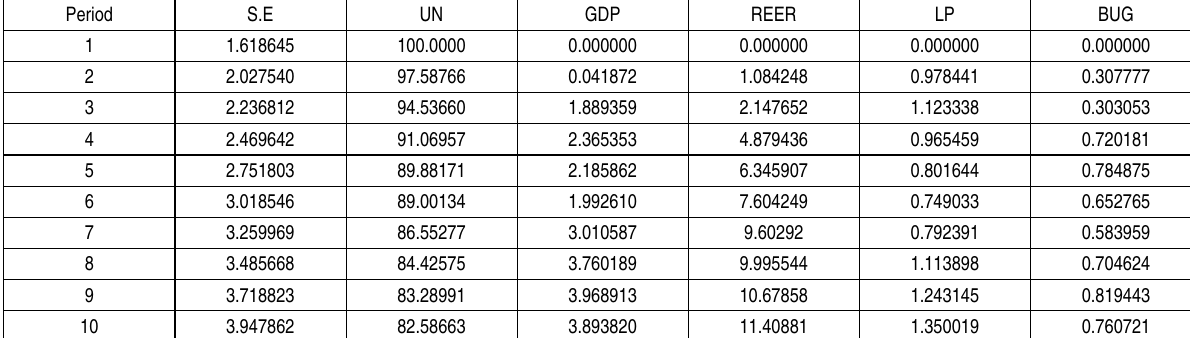
Table 8. Variance decomposition